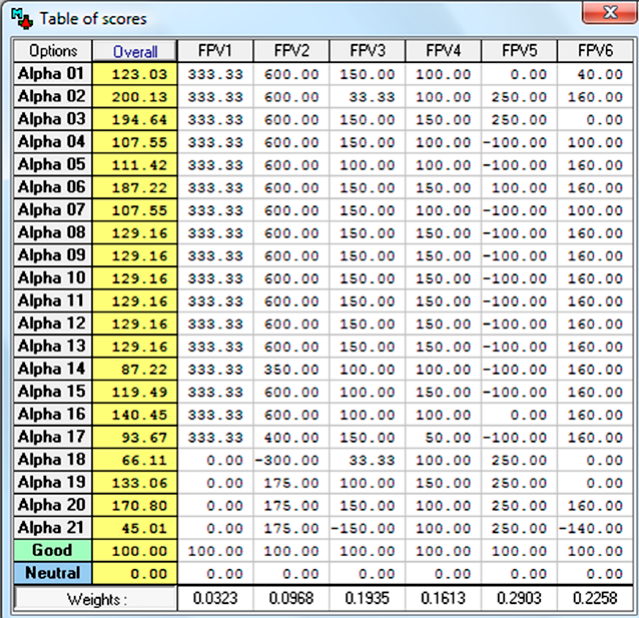
Table 3. Partial values and overall loyalty revealed by the twenty